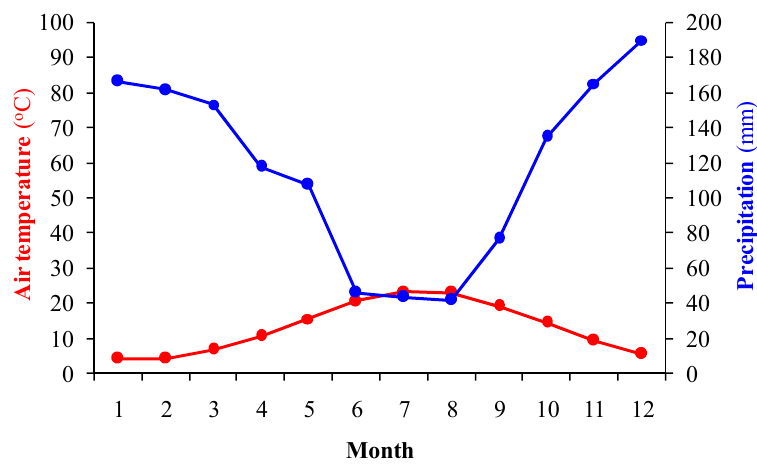
Figure 1. Pluviothermic diagram of the study area.